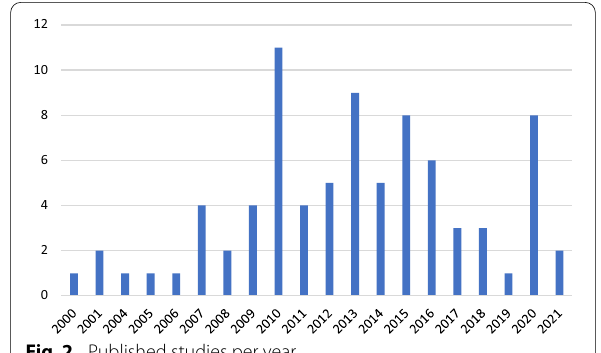
Fig. 2. Published studies per year